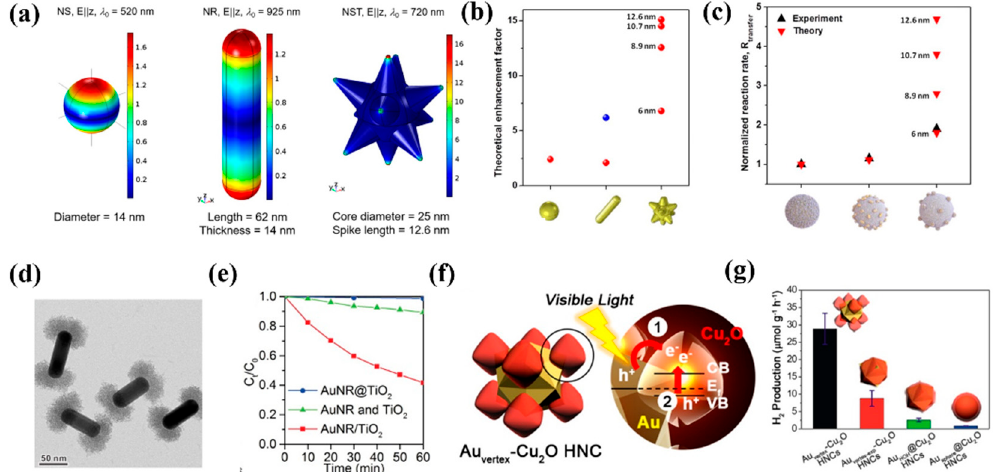
Figure 3. “Tip hot spots” e ff ects in plasmon-mediated heterostructures. ( a ) Calculated distributions of electromagnetic (EM) fields in nanospheres, nanorods and nanostars (from left to right). ( b ) Theoretical EM field enhancement factor in three typical metals. In the Au nanorod, the blue dot and red dot correspond to the EM field paralleled and perpendicular to the nanorods, respectively. In the Au nanostar, the di ff erent spike lengths, combined with a core of 25 nm, were calculated. ( c ) The theory and experiment results for the rates of the HCs’ generation in SiO 2 loaded Au@TiO 2 . ( a – c ) Reproduced with permission. [63] Copyright 2016, American Chemical Society. ( d ) The morphology of the Au nanorods@TiO 2 dumbbells presented by transmission electron microscope (TEM). ( e ) The comparison of the rates of degradation of methyl blue (MB) in di ff erent Au rods / TiO 2 heterostructures. ( d , e ) Reproduced with permission. [64] Copyright 2016, American Chemical Society. ( f ) The scheme of Au nanocubes@Cu 2 O heterostructures. ( g ) The amounts of H 2 generation in four kinds of Au / Cu 2 O heterostructures. ( f , g ) Reproduced with permission. [65] Copyright 2016, American Chemical Society.